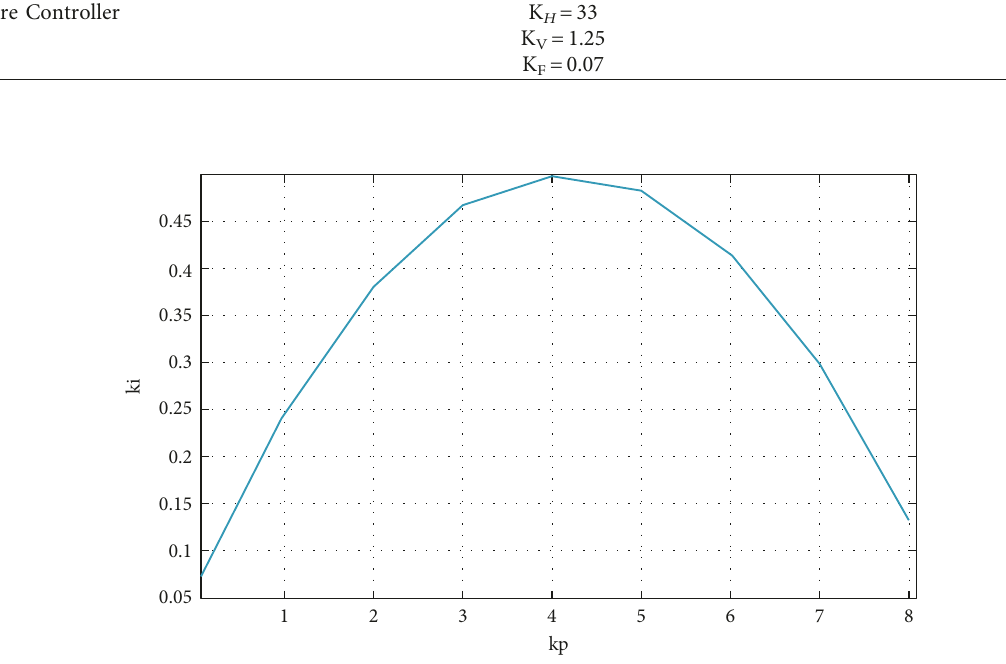
Figure 3: K I determined values for various K P values.